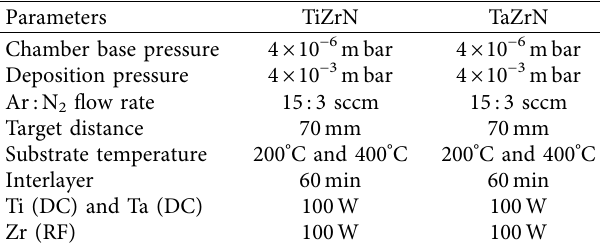
Table 1: Operating parameters for deposition of TiZrN/TaZrN thin film